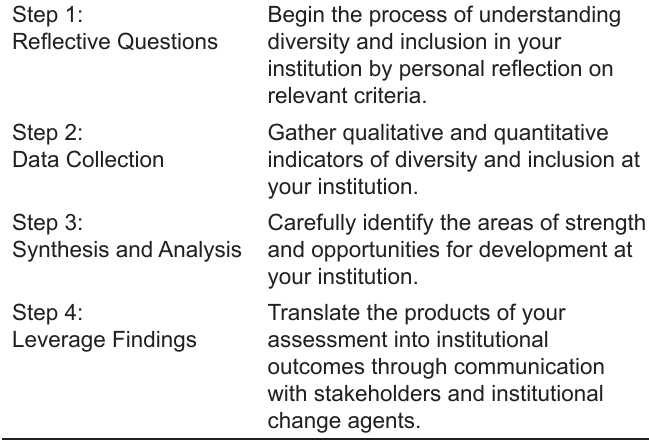
Table 4. American Association of Medical Colleges four-step process* for assessing institutional